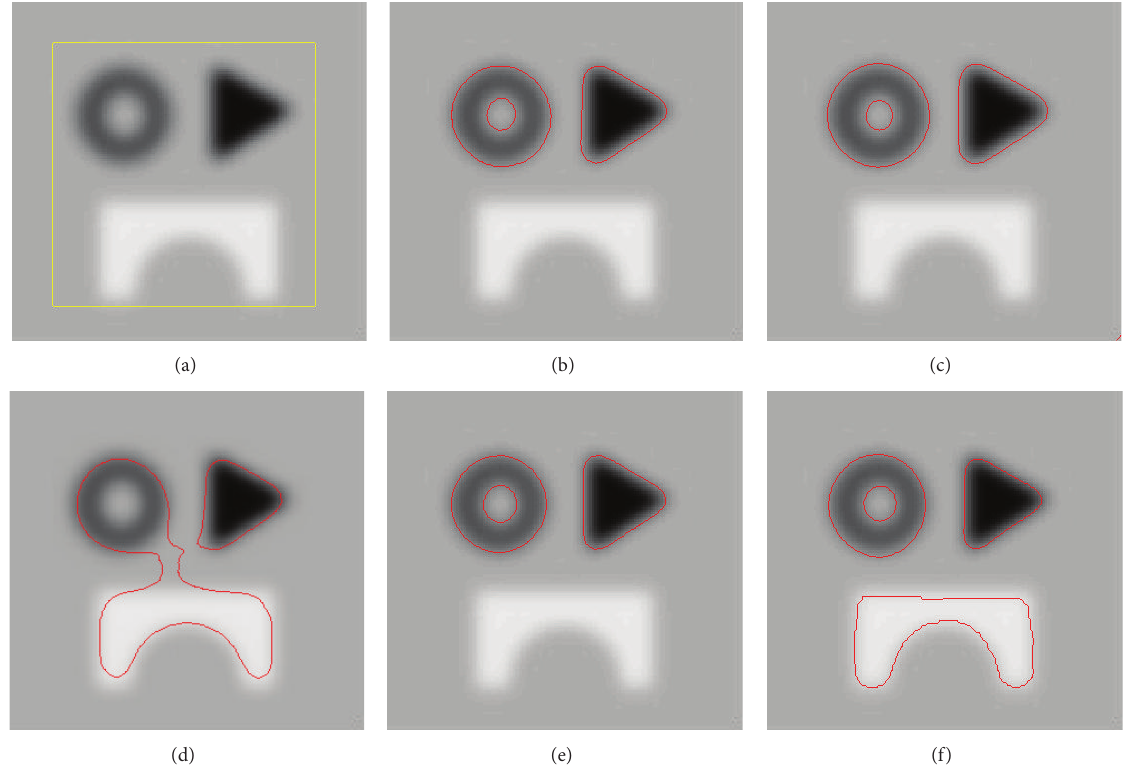
Figure 7: Segmentation results on a synthetic image: (a) the initial contour, (b) the CV model result, (c) the GACV model result, (d) the DRLSE model result, (e) the FAC model result, and (f) the LFAC model result.